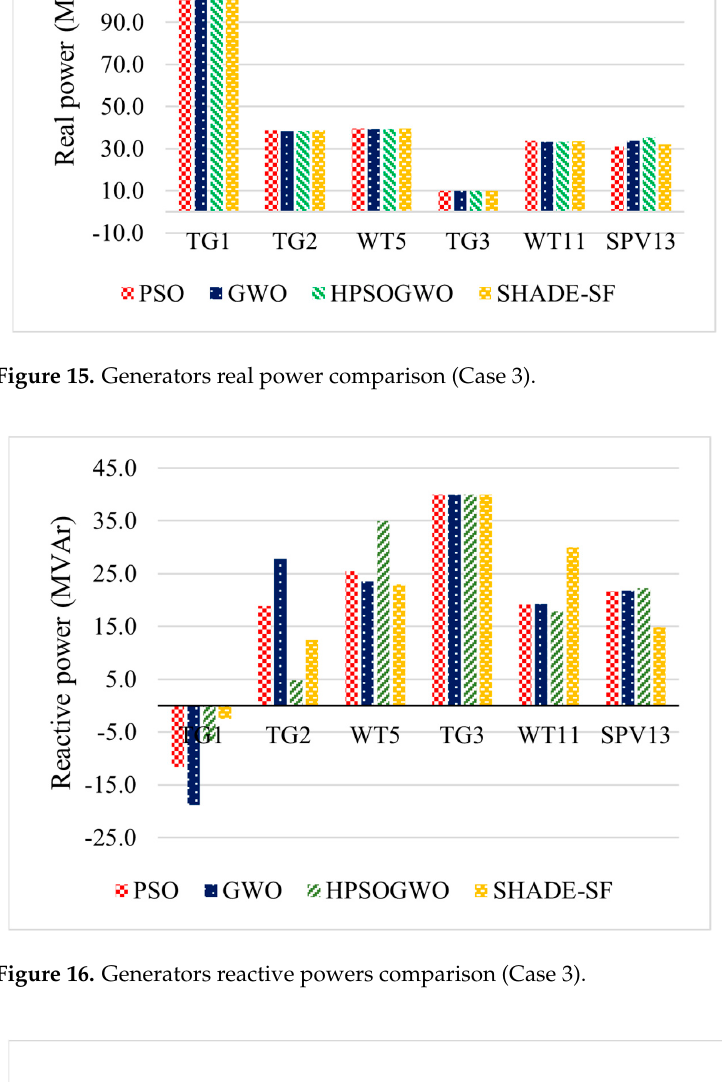
Figure 14. Generator bus voltages comparison (Case 3).